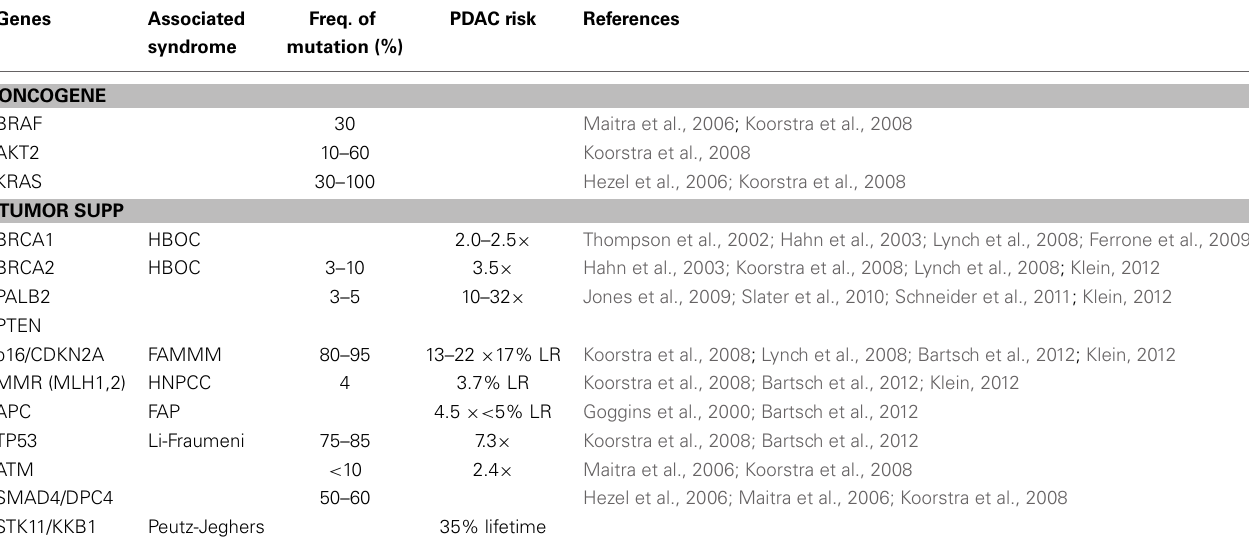
Table 1 | Pancreatic cancer susceptibility